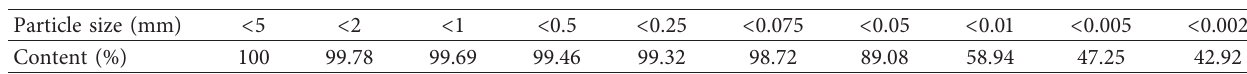
Table 2: Particle size distribution and its ratio of red clay